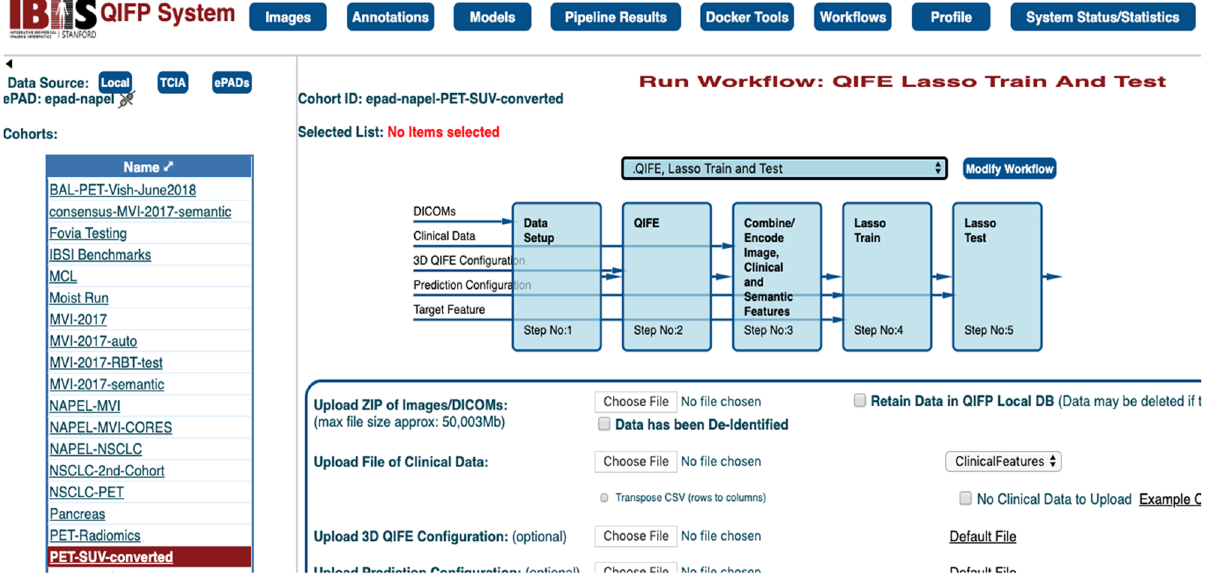
Fig. 2 Quantitative Imaging Feature Pipeline. This shows an example of the quantitative imaging feature pipeline (QIFP) used to process a positron emission tomography (PET) imaging cohort stored on a local network ePAD server. The box next to the “ modify work fl ow ” button is a selection button, which has been set to choose the work fl ow displayed. This work fl ow moves the image data into Stanford ’ s Quantitative Image Feature Engine (QIFE) 64 , which computes thousands of image features for each segmented tumour in the cohort, followed by a sparse regression modeler (LASSO TRAIN) that derives an association between a linear combination of a small number of image features to 5-year survival, and fi nally tests that model in an unseen cohort and produces an ROC curve displaying the accuracy of the association. Other work fl ows can be chosen that use one or more of the existing tools stored on the QIFP